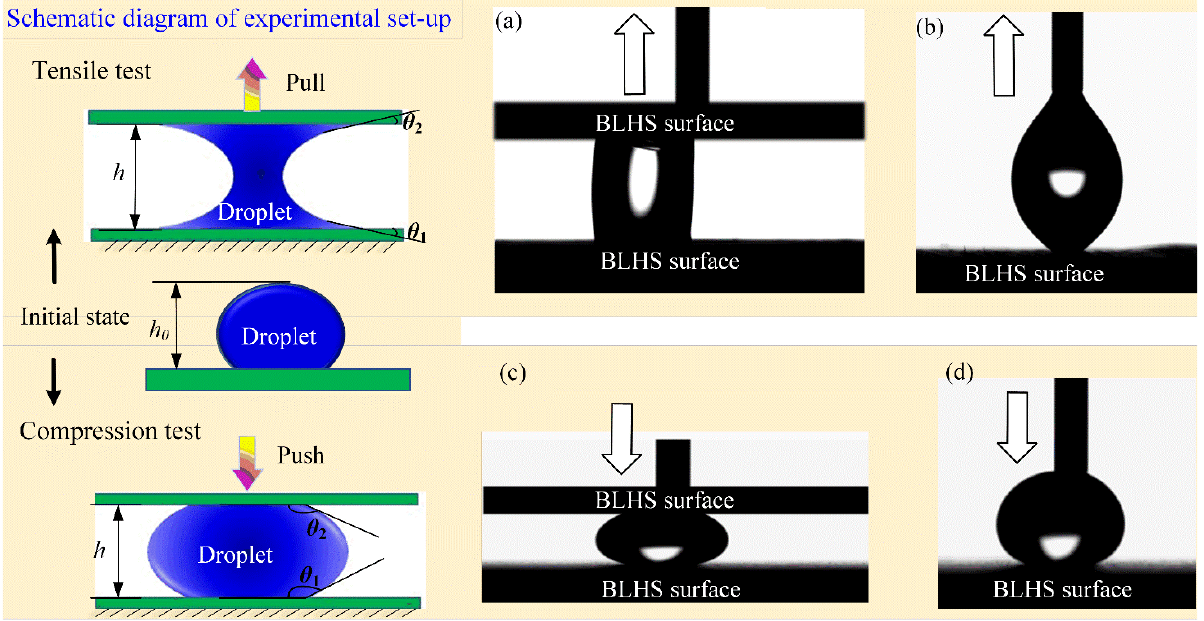
Figure 11. The BLHS surface adhesive ability experiments. Droplet ( a ) stretched up by a BLHS sur- face; ( b ) stretched up by a flat-end needle; ( c ) compressed by a BLHS surface; and ( d ) compressed by a flat-end needle.